Question: How would you classify this visualization?
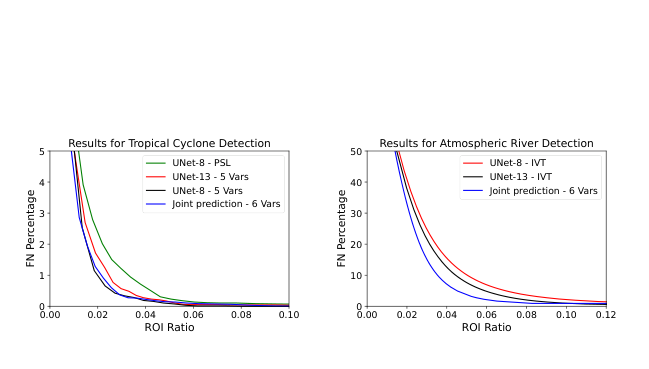
Answer: line